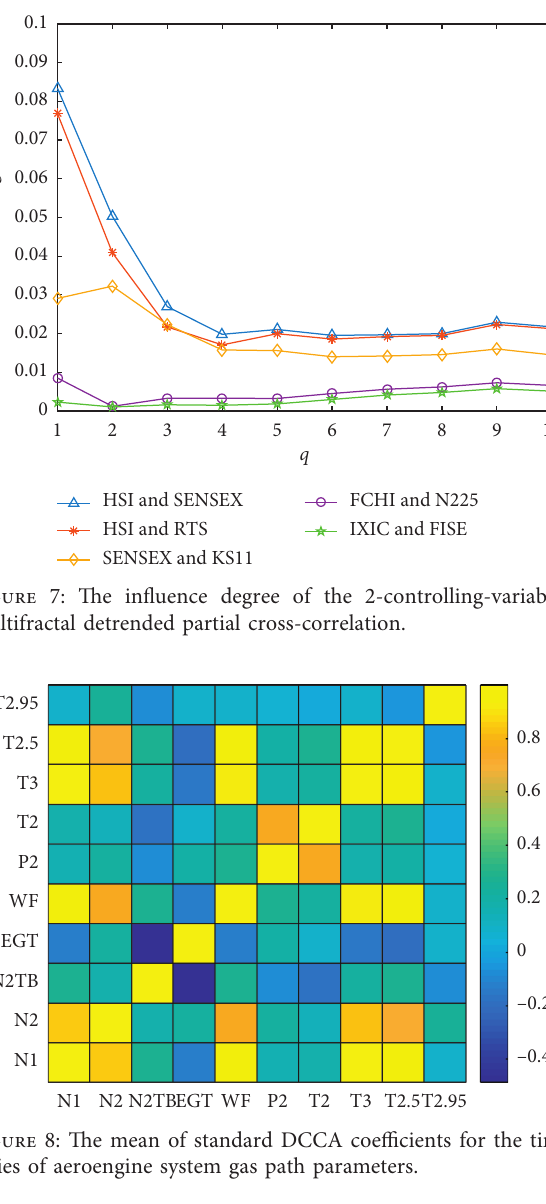
Figure 6: The influence degree of the 2-controlling-variables detrended partial